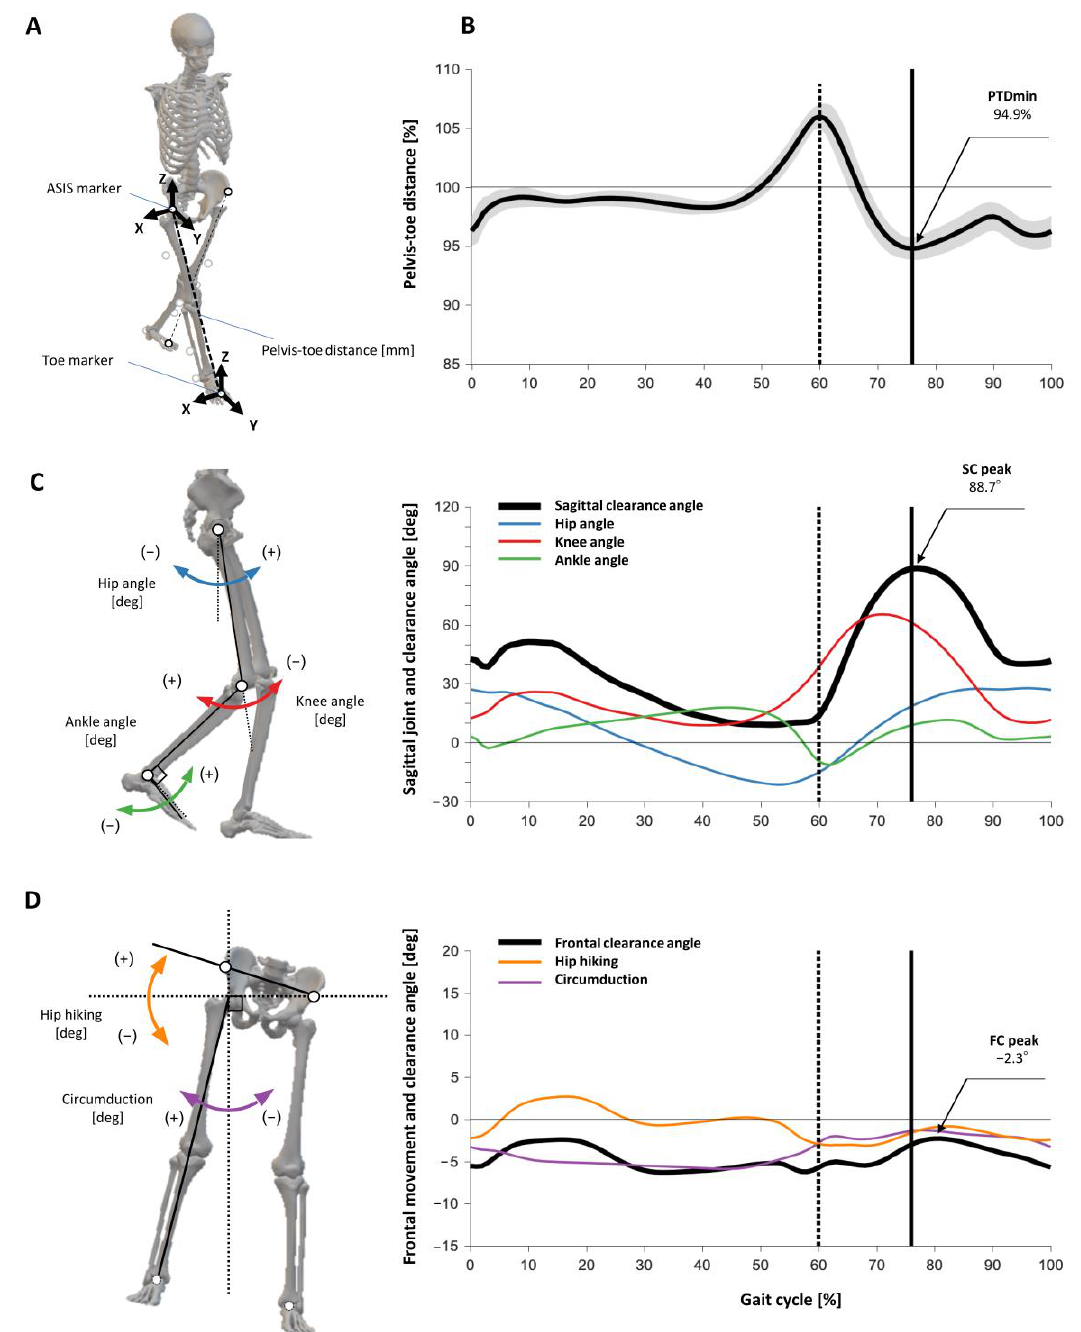
Figure 1. Indexes of gait outcomes in healthy controls. ( A ) Pelvis-toe distance (PTD) was the 3-dimensional distance between the unilateral ASIS and toe marker; ( B ) Plot of PTD during the gait cycle normalized by bilateral stance (%PTD). Mean plot was shown as black line, and standard deviations were shown in the gray range. PTDmin was defined as the first minimum peak value during the swing phase; ( C ) Sagittal angles of the lower limb and their definitions. Sagittal plane angle plots of the hip, knee, ankle joint, and summation of the sagittal clearance angle. The SC peak was defined as the maximum peak value during the swing phase. ( D ) Frontal angles of hip hiking and circumduction and their definition. Frontal plane angle plot of hip hiking, circumduction, and summation of the frontal clearance angle. The FC peak was defined as the maximum peak value during the swing phase. In ( B – D ), vertical dashed lines indicate toe-off timing and solid vertical lines indicate PTDmin